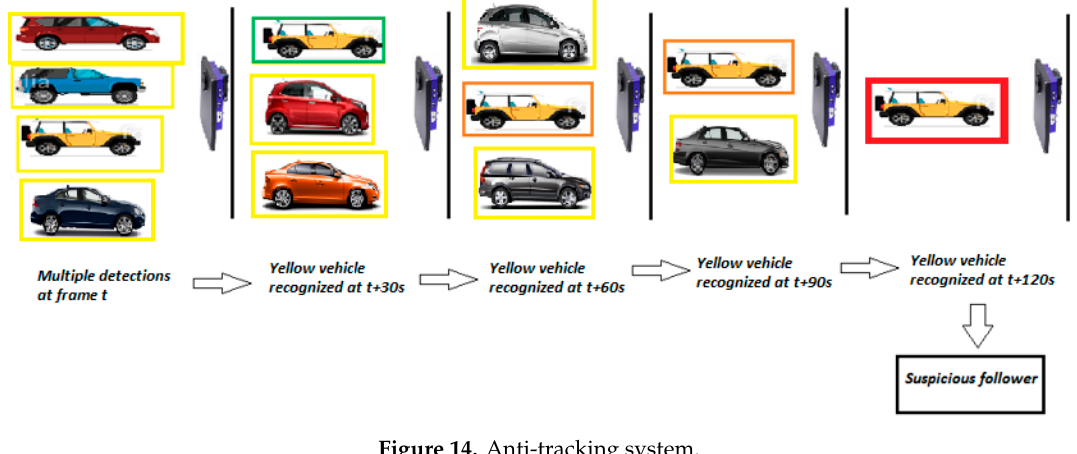
Figure 14. Anti-tracking system.